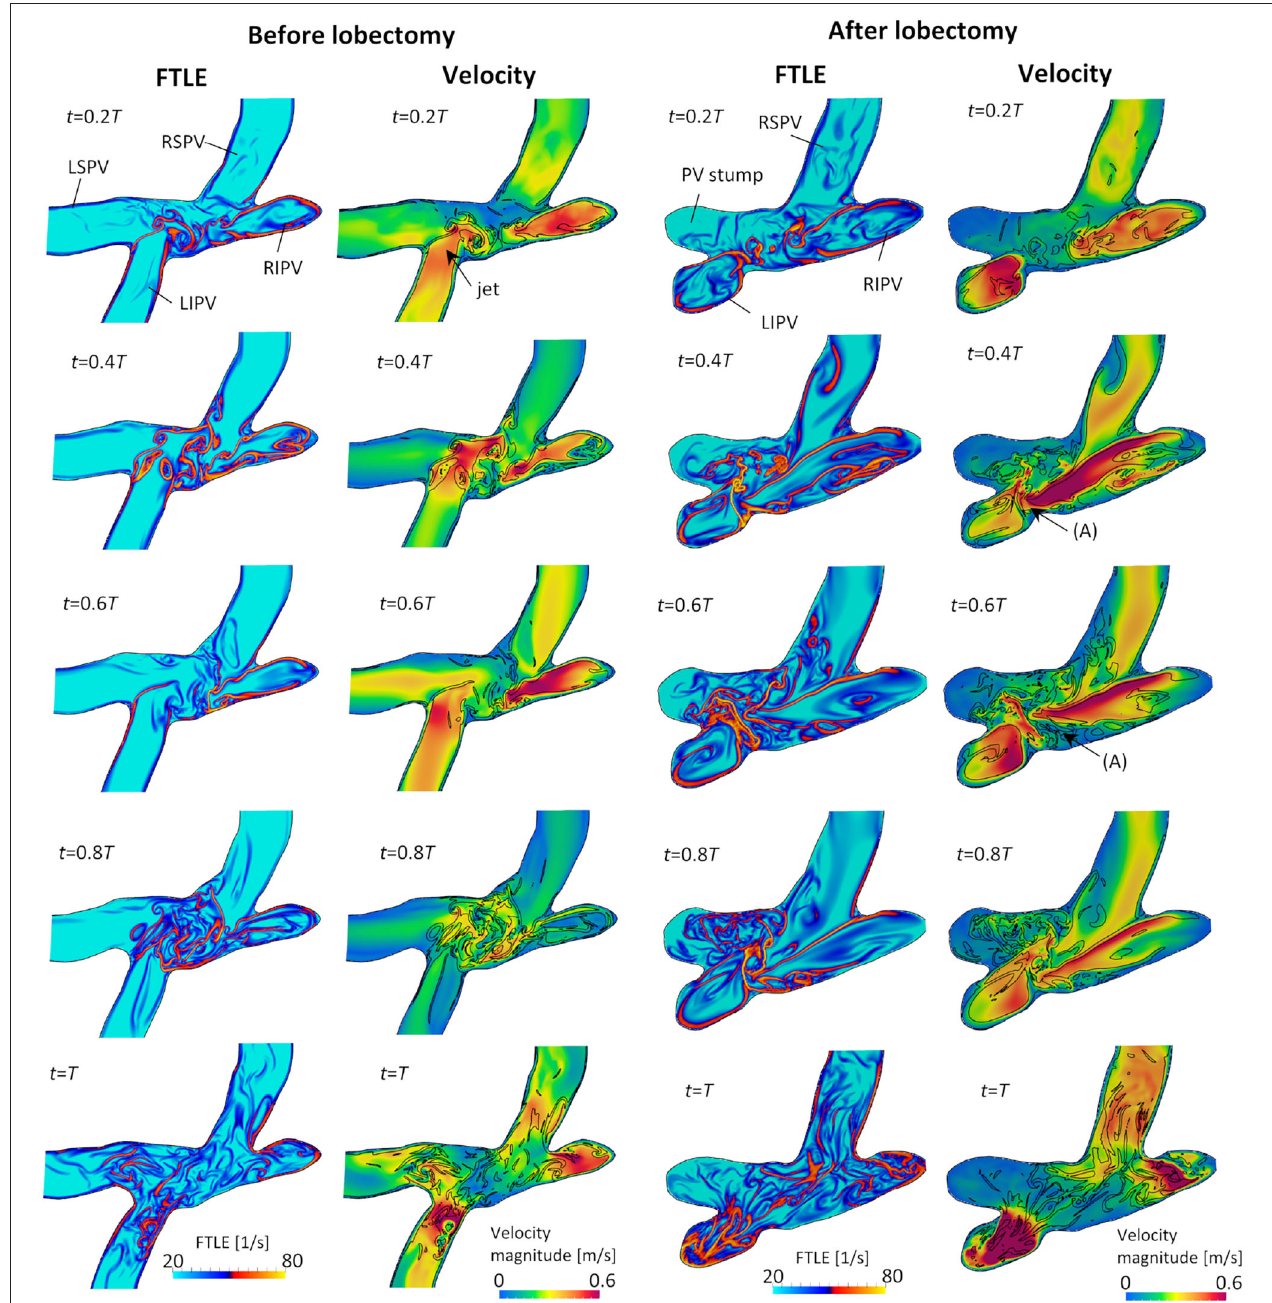
FIGURE 7 | Cross-sectional views of the backward finite-time Lyapunov exponent (FTLE) and velocity distribution with attracting Lagrange coherent structure defined as an iso-surface of an FTLE of 40 s − 1 at t = 0.2 T , 0.4 T , 0.6 T , 0.8 T , and T before and after the left upper lobectomy ( T : cardiac cycle from start of